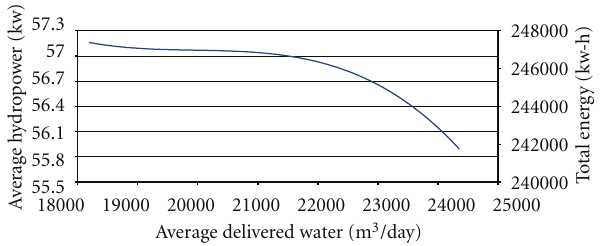
Figure 6: Average delivered water versus produced hydropower and